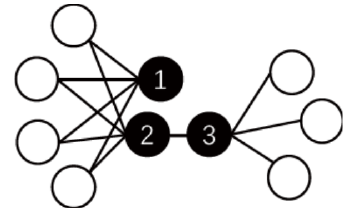
Fig. 1 A simple example of network. From the point of view of first-order proximity, vertex 2 and vertex 3 should be closer in low-dimensional space because they connect directly to each other through an edge. In consideration of second- order proximity, vertex 1 and vertex 2 should be more similar in low-dimensional space as they share similar